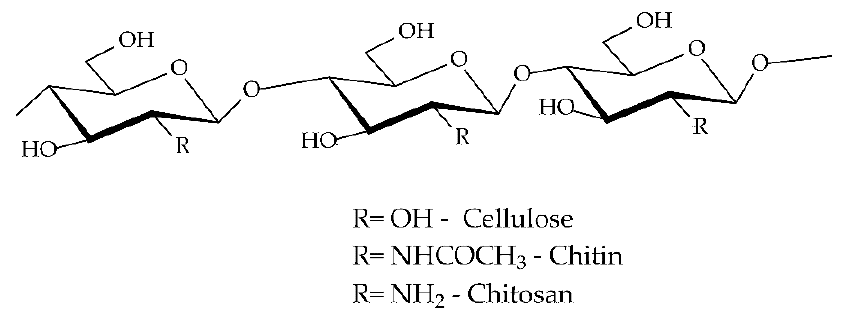
Figure 3. Comparison among cellulose, chitin, and chitosan structures.